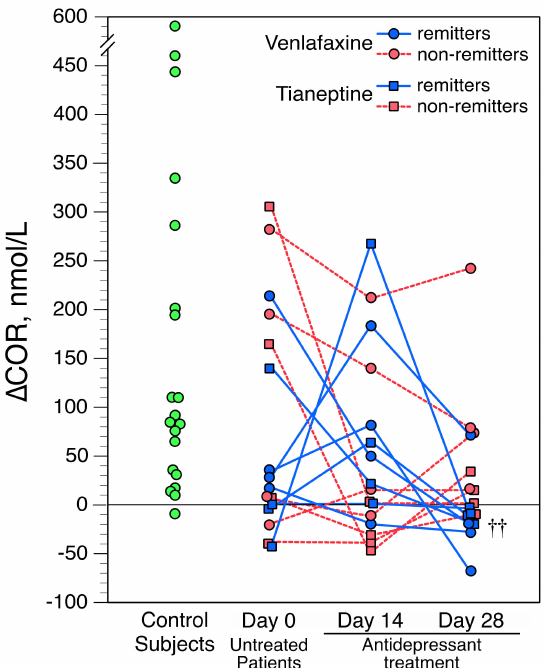
Figure 2. Apomorphine-induced cortisol stimulation (i.e., ∆ COR) in controls and in depressed patients. Values are plotted individually. Regarding patients, circles represent those treated with venlafaxine; squares represent those treated with tianeptine; subsequent remitters (after 6 weeks of treatment) are marked in blue, non-remitters are in red. Threshold for a blunted ∆ COR value, <0 nmol/L. Comparison between remitters and non-remitters on Day 28, †† p < 0.01 (by Mann– Whitney two-tailed U